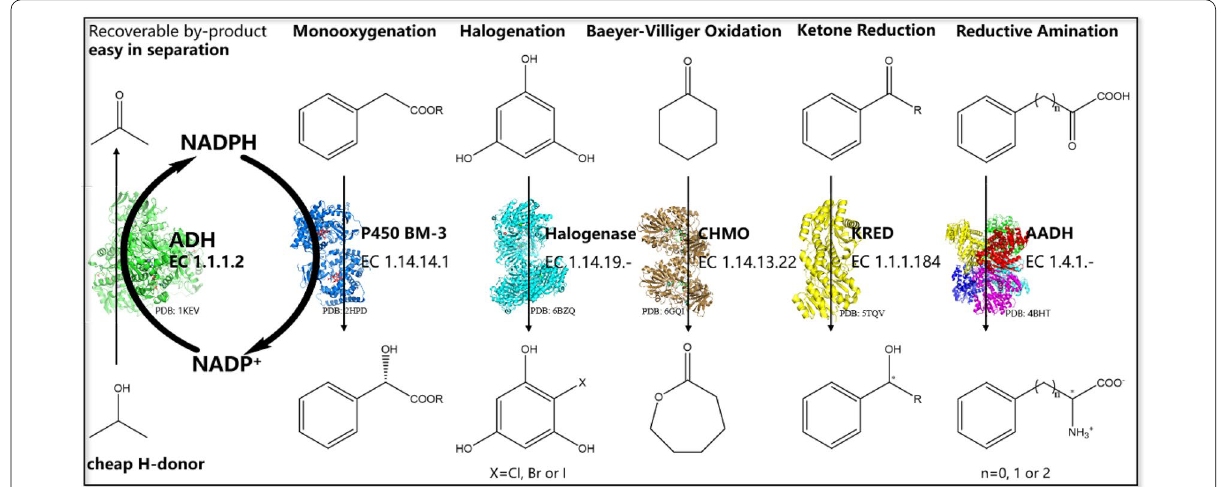
Fig. 1 Biosynthetic reactions using